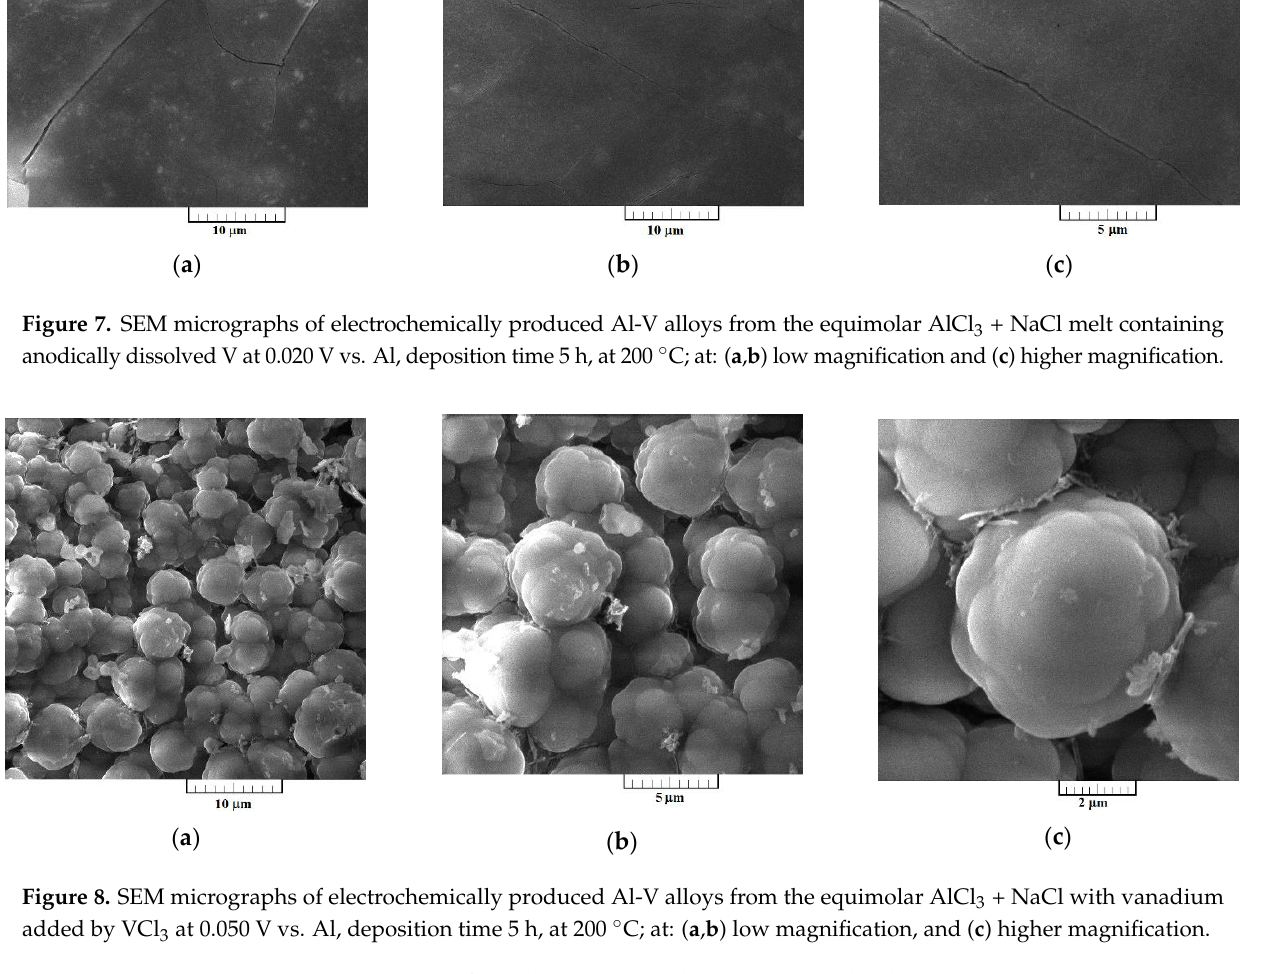
Figure 8. SEM micrographs of electrochemically produced Al−V alloys from the equimolar AlCl 3 + NaCl with vanadium added by VCl 3 at 0.050 V vs. Al, deposition time 5 h, at 200 °C; at: ( a , b ) low magnification, and ( c ) higher magnification.